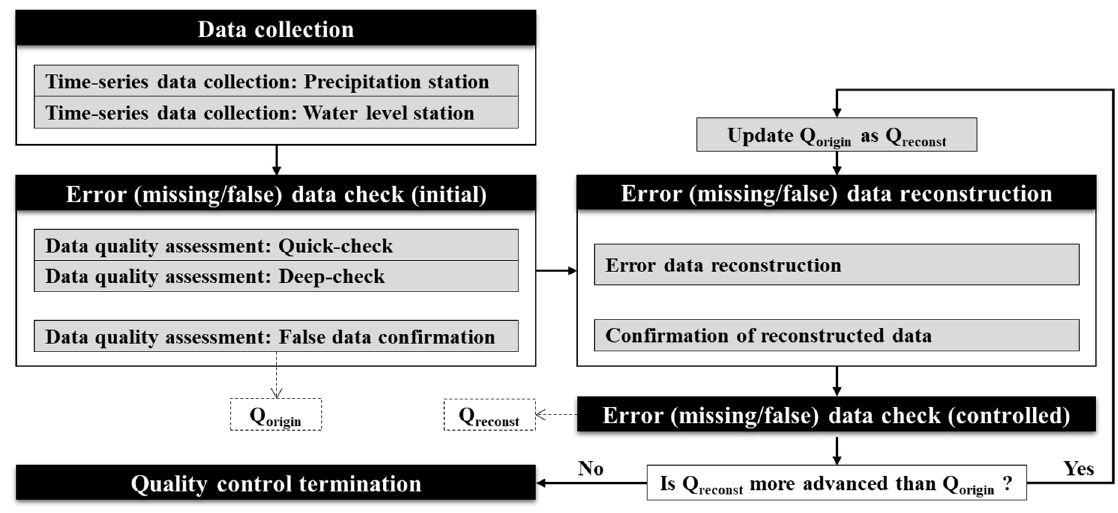
Figure 1. Scheme of proposed quality control process.